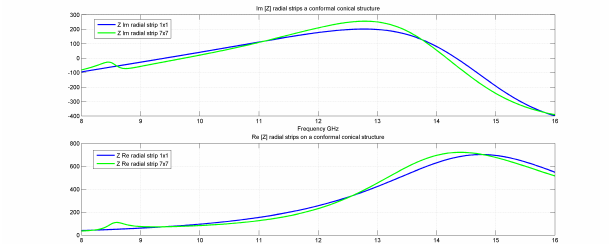
Fig. 5. Imaginary part (top panel), and real part (bottom panel) of Z A of the isolated curved wire (blue line) and the wire surrounded by identical passive ones (green line)